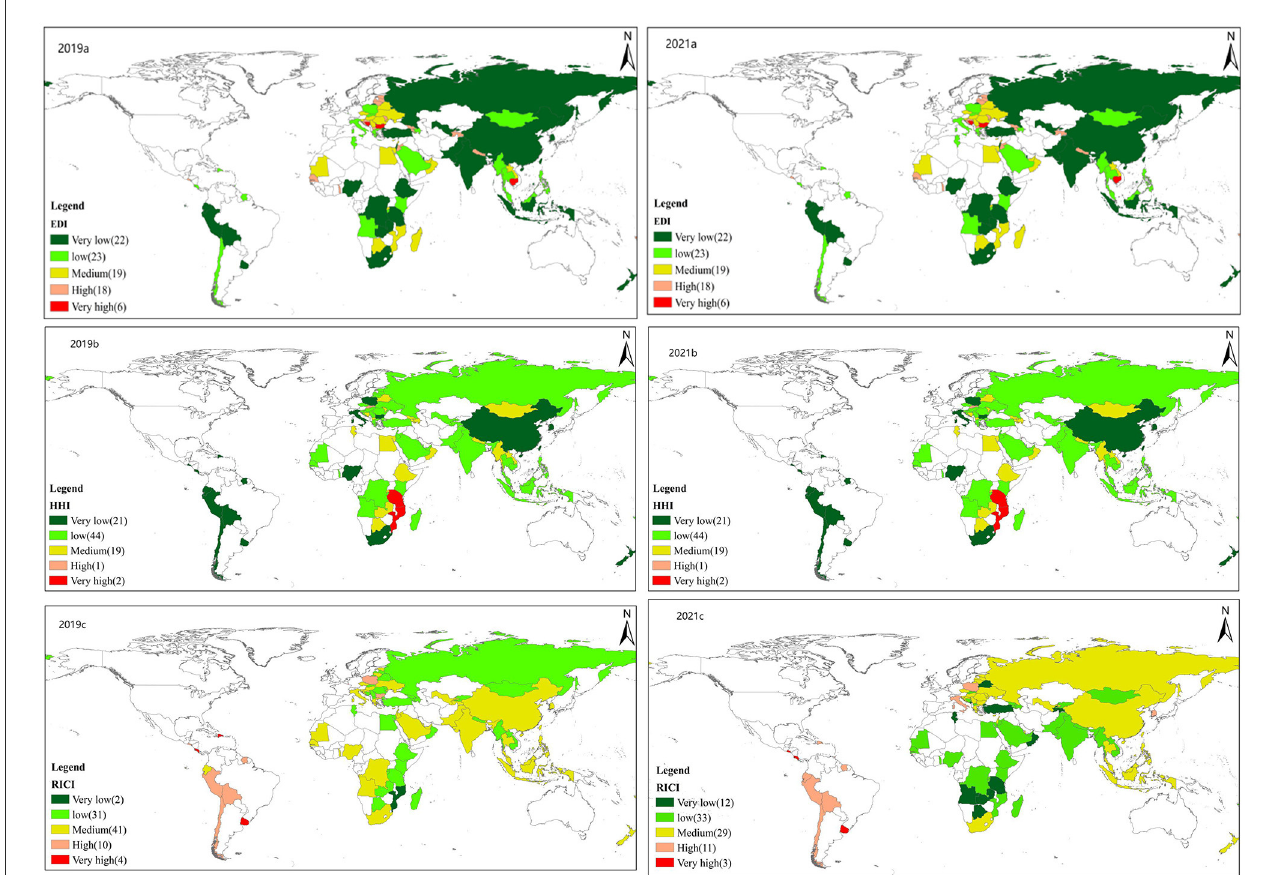
FIGURE5 Spatial pattern of Agricultural products security risks. a, EDI; b, HHI; c, RICI in 2019 and 2021.